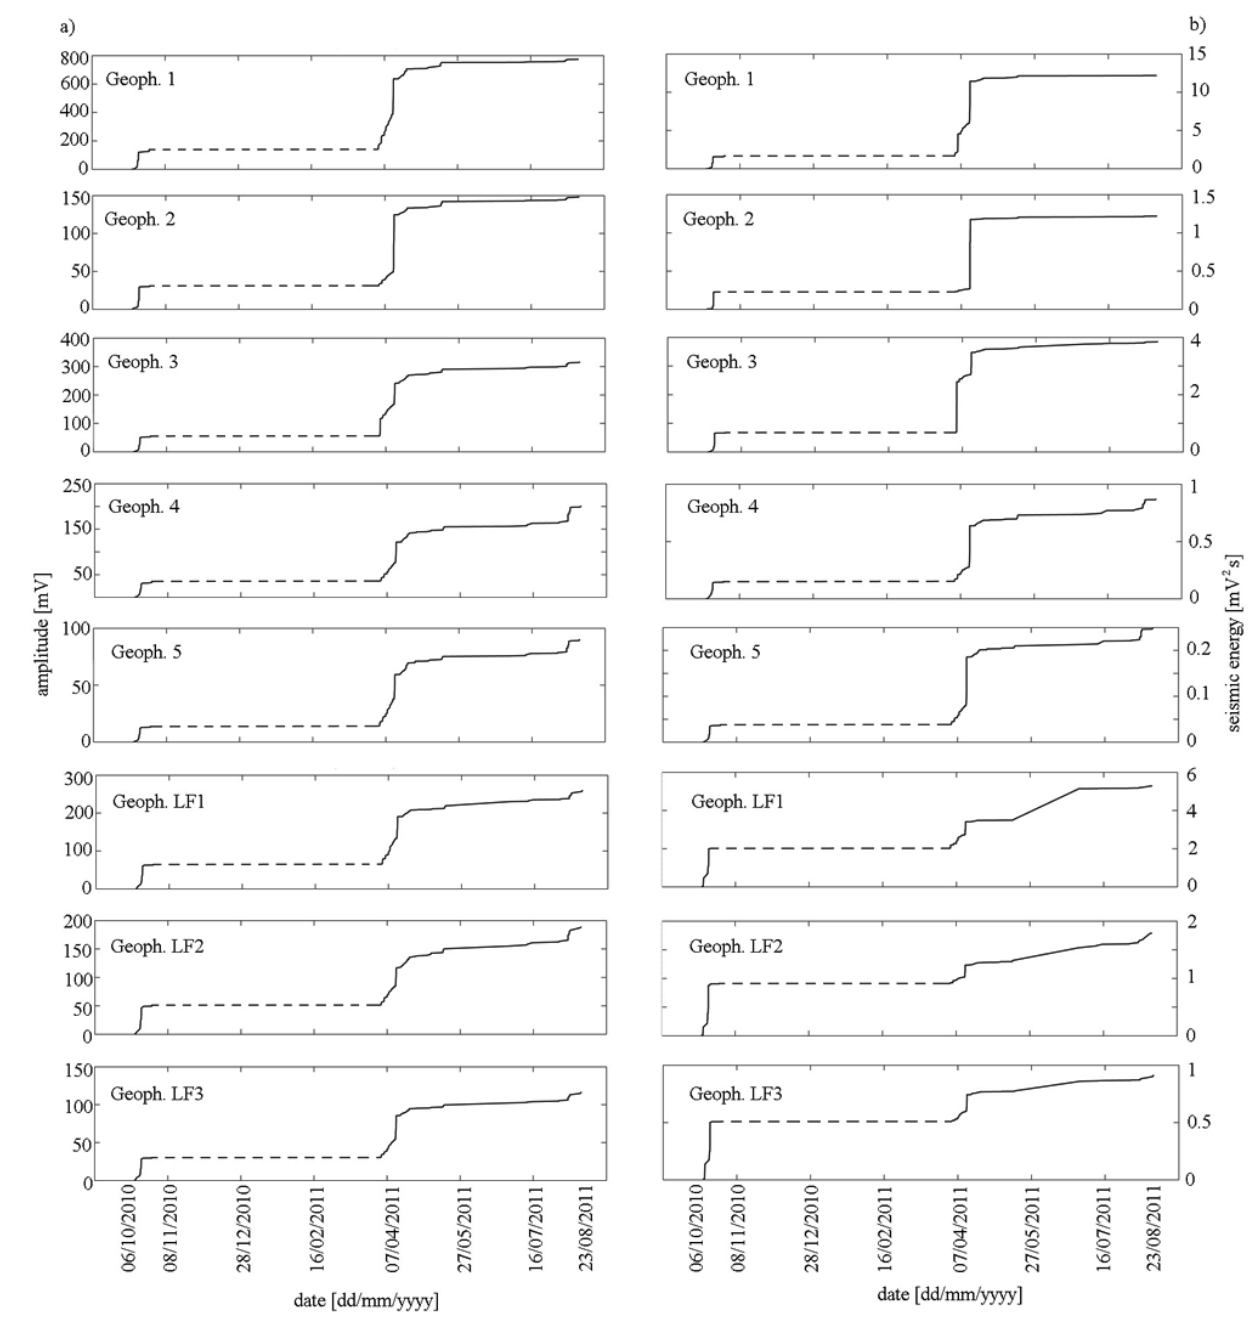
Fig. 9. Cumulative distribution of the (a) maximum amplitude and (b) seismic energy of the 167 single events recorded by each geophone. The dashed line represents the no-data